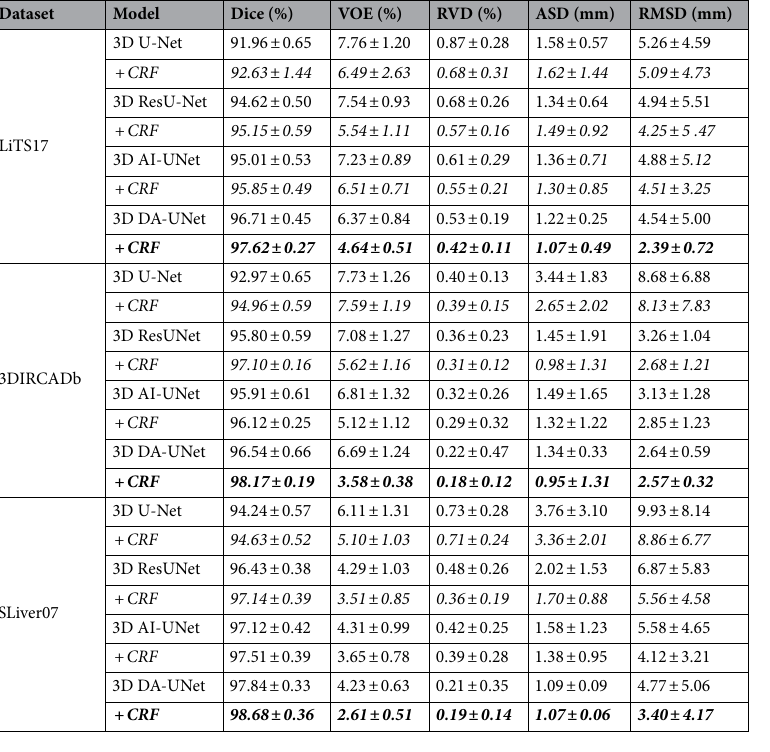
Table 2. Quantitative analysis results of ablation experiments on three databases. Significant values are in bolditalics and